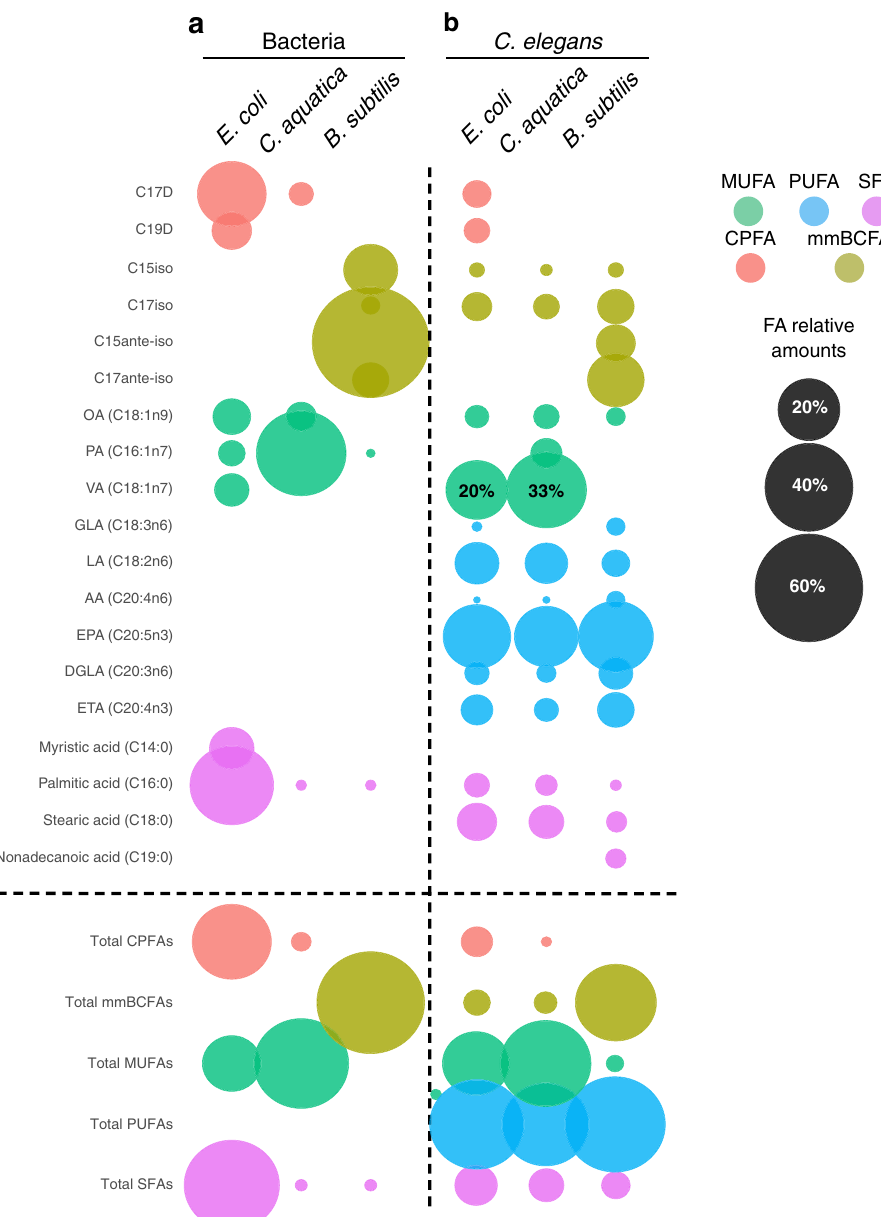
indicative of absolute quantities. Ratios are available in SupplementaryTables3, 4. Data were represented as the mean of three independent biological replicates. Statistical pairwise comparisons are available in Supplementary Table Data File. Source data are provided as a Source Data fi